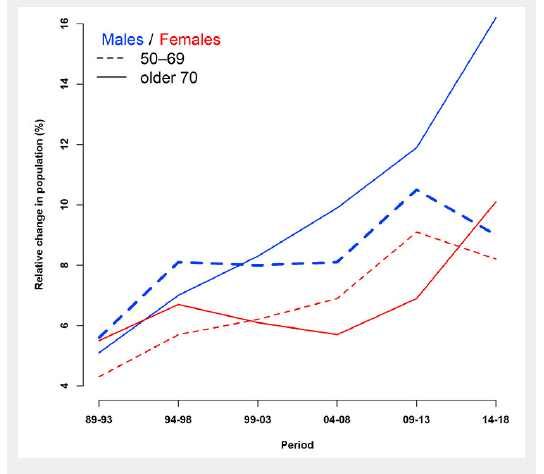
Relative change in population (in % based on preceding year) for males (red) and females (blue) and age groups 50–69 (dashed) and ≥70 years.